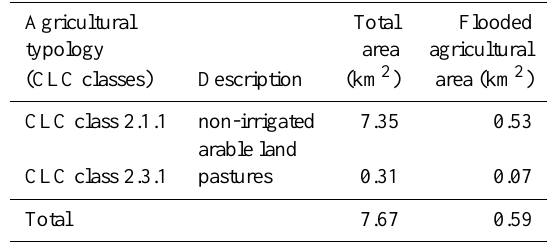
Table 15. Statistics on the risk for agriculture for different CLC